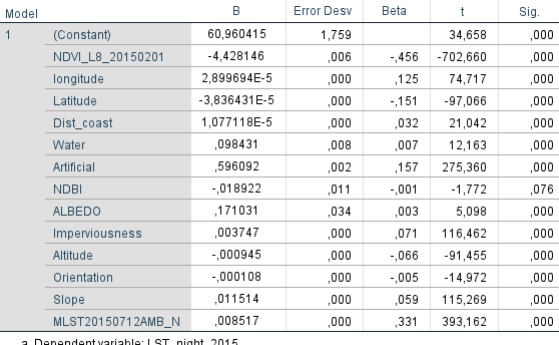
Table 2. “Hybrid” OLS model oh nighttime LST